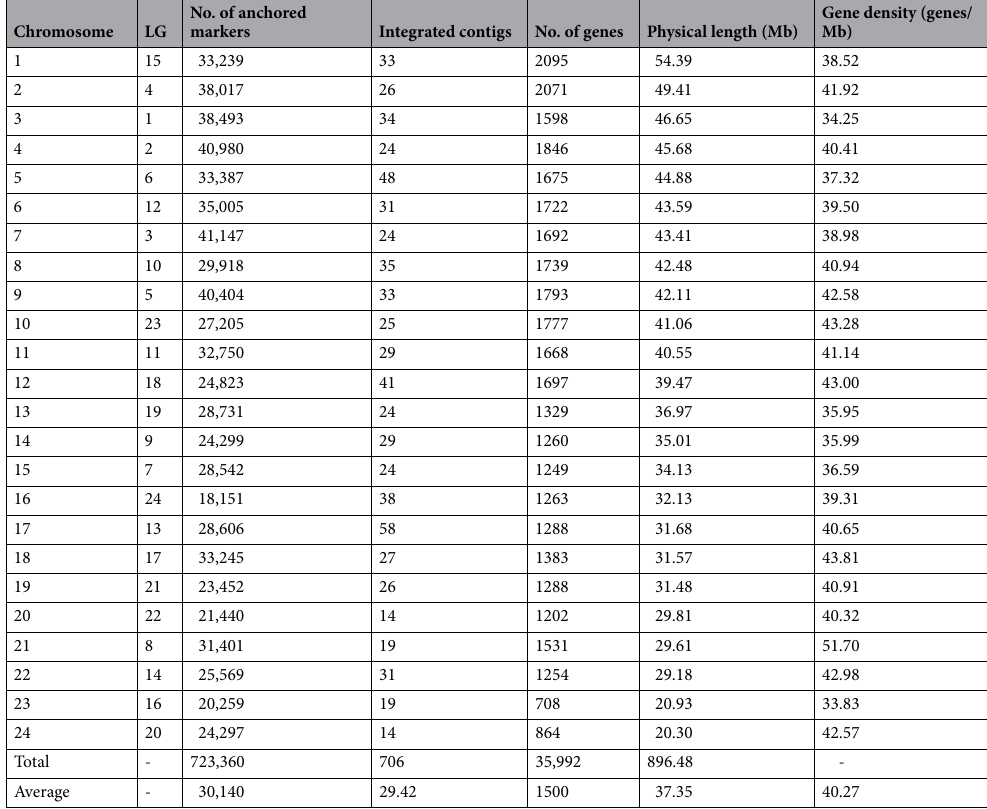
Table 4. Description of chromosomes ordered by size with corresponding LG. LG: linkage group, Mb: